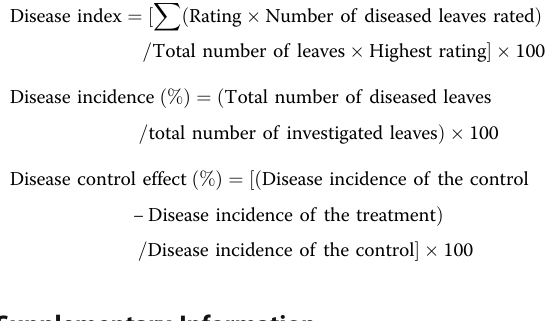
Additional file 1: Figure S1. Genome map of Bacillus subtilis 9407. Figure S2. BRIG based on homology with B. subtilis 168. Figure S3. Schematic diagram of secondary metabolite clusters in the B. subtilis 9407 and 168 genomes. Figure S4. Growth curve of B. subtilis 9407 and mutant strains. Additional file 2: Table S1. Strains and plasmids used in this study. Table S2. Functional genes involved in biocontrol traits in B. subtilis 9407 and B. subtilis 168. Table S3. GeneBank accession numbers of the strains used in this study. Abbreviations ANI: Average nucleotide identity; Blast: Basic local alignment search tool; BFB: Bacterial fruit blotch; BGCs: Biosynthesis gene clusters; BRIG: BLAST